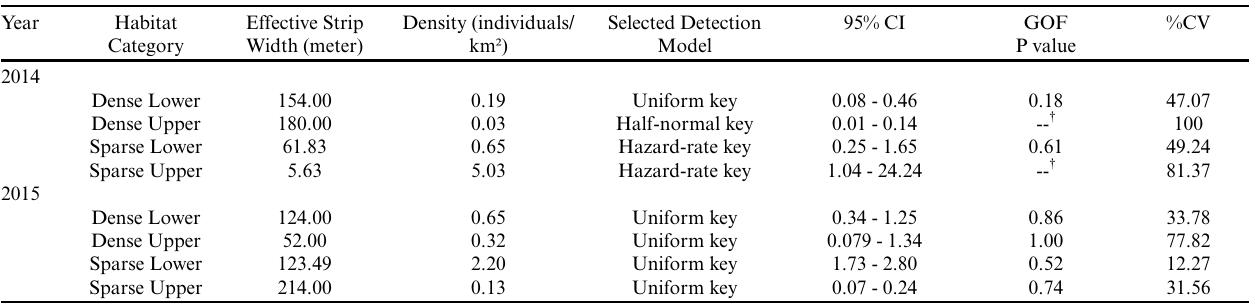
Table 4 . Density estimates (individuals/km²) for Kori Bustards ( Ardeotis kori ) in each habitat type surveyed June–July 2014 and May– July 2015 within the Northern Tuli Game Reserve, Botswana. All selected detection models run with cosine